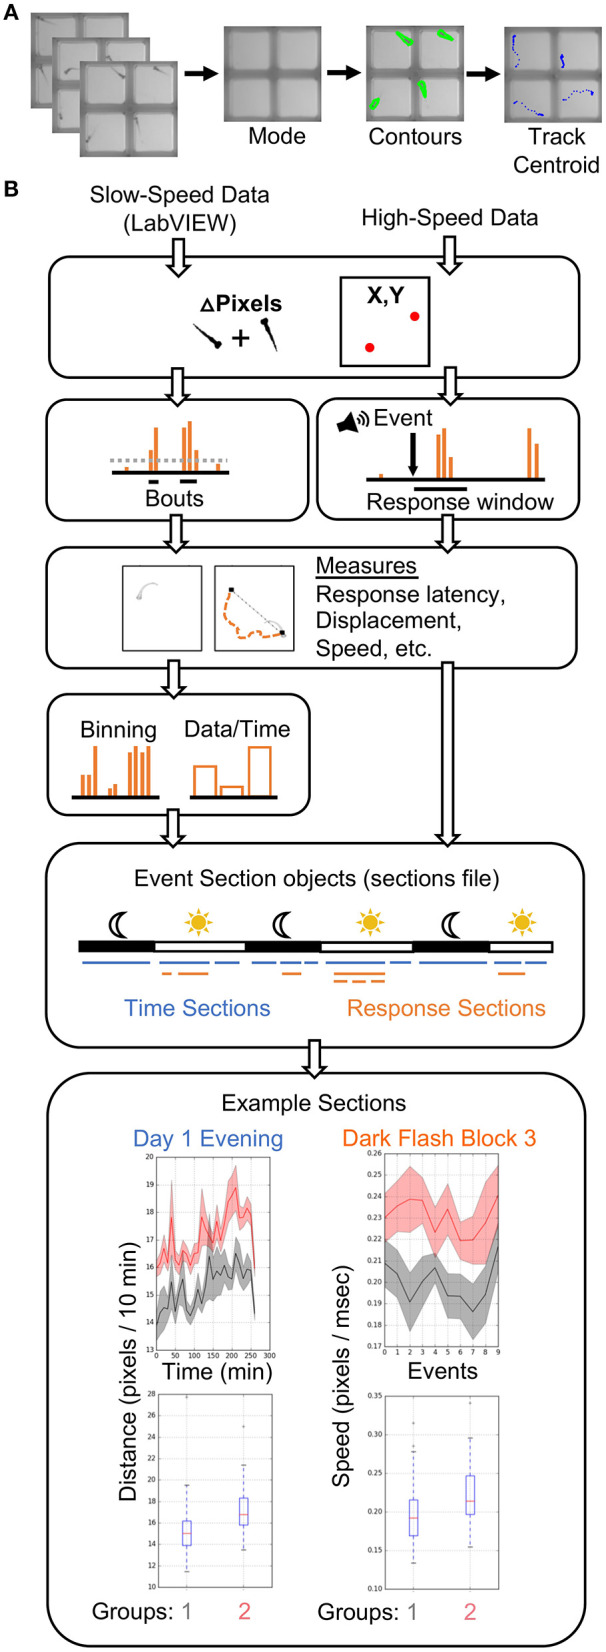
Data Analysis Pipeline. (A) The high-speed movies are analyzed by calculating and subtracting a mode image to define frame-by-frame fish contours in each well or ROI, and tracking the centroid of each fish to generate delta pixel and position data. (B) Overview of high- and slow-speed data processing and group comparisons. Fish objects contain all metrics for each fish as well as its genotype (gray = group 1, red = group 2). For slow-speed data, bouts are identified using the delta pixel and positional information. Thresholds are set depending on input data type. Stimulus responses are identified analogously, but are identified with high-speed movie frames. Movement and response features are then calculated, binned if slow-speed data, and plotted based on user defined event sections. For example, slow-speed data is processed in sections based on time, such as “Day 1 Evening” or “Day 2 Night.” High-speed data processing considers only the high-speed movie information in a given section, such as the 10 dark flashes in “Dark Flash Block 3.” Sections can be overlapping. Current outputs include both a ribbon plot and a box plot for each metric.